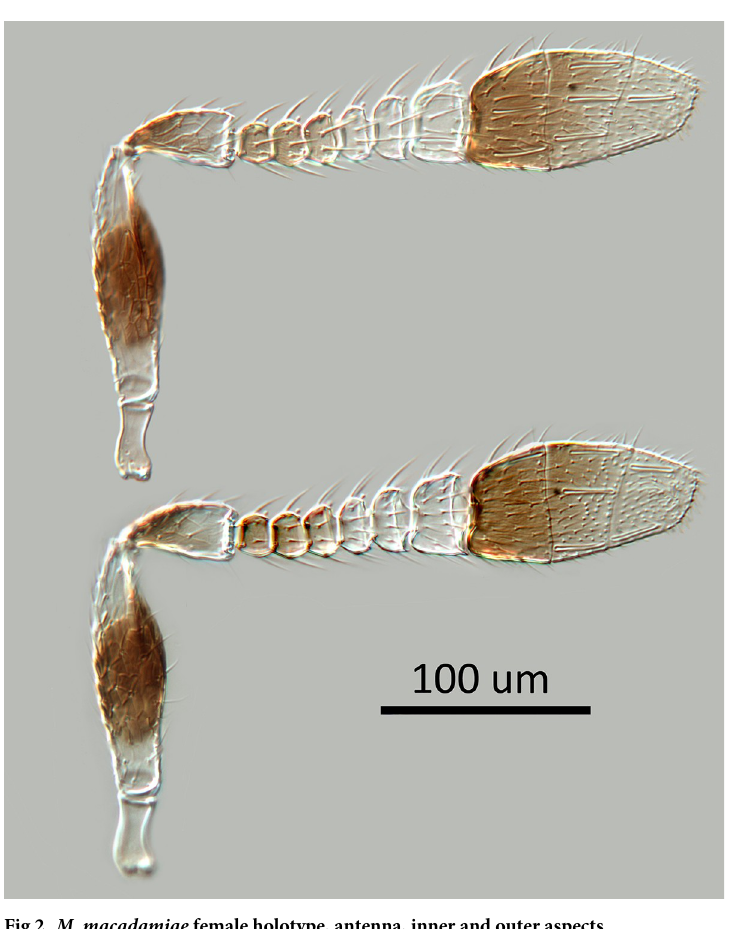
Fig 2. M . macadamiae female holotype, antenna, inner and outer aspects.